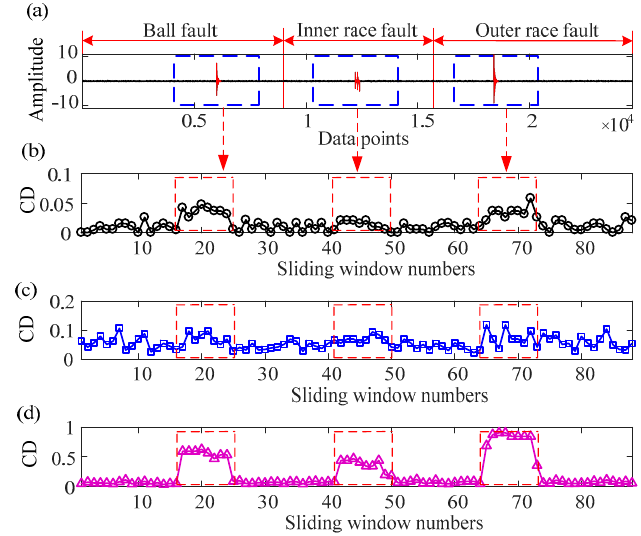
Figure 6. Results of sliding window analysis of LZC, MLZC, and HLZC methods with Chebychev distance (CD): ( a ) the simulated impulsive signal, ( b ) the CD value of LZC, ( c ) the CD value of MLZC, and ( d ) the CD value of HLZC.